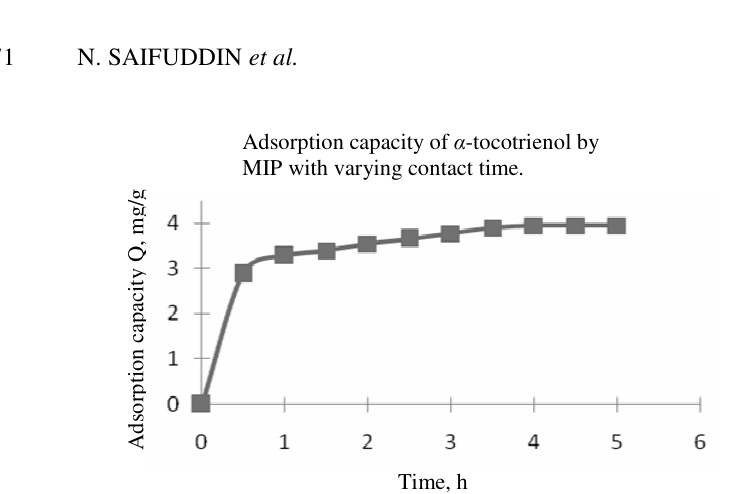
Figure 8. Adsorption dynamics of α -tocotrienol on the cross-linked chitosan-polyacylamide MIP beads. V of analyte = 25 mL; Concentration of analyte = 0.170 mg/mL; MIP quantity = 1.0 g; T = 25 o C